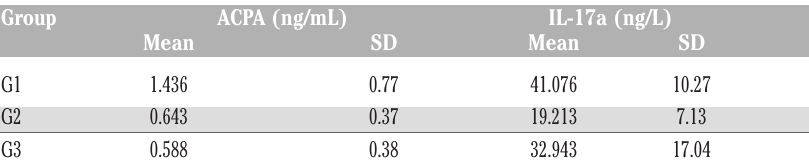
Table 1. Description of differences in ACPA and IL-17a levels between experimental groups.